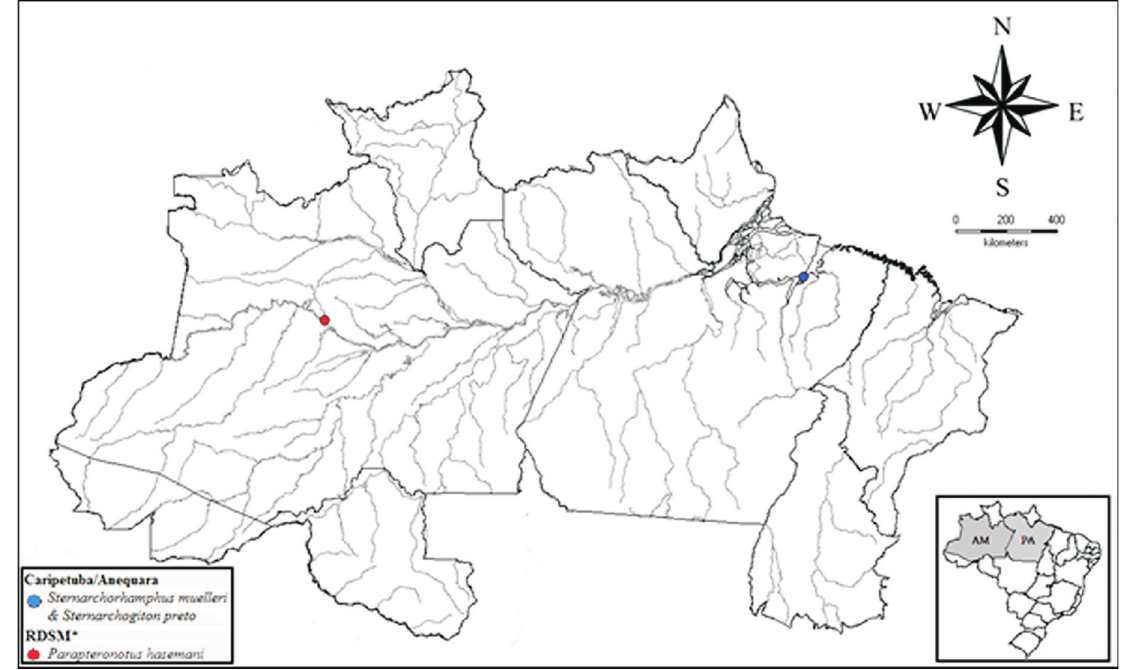
Figure1 -Mapofthecollectionsitesofthe Sternarchorhamphusmuelleri,Parapteronotushasemani and Sternarchogitonpreto specimens(*Reservade Desenvolvimento Sustentável Mamirauá,